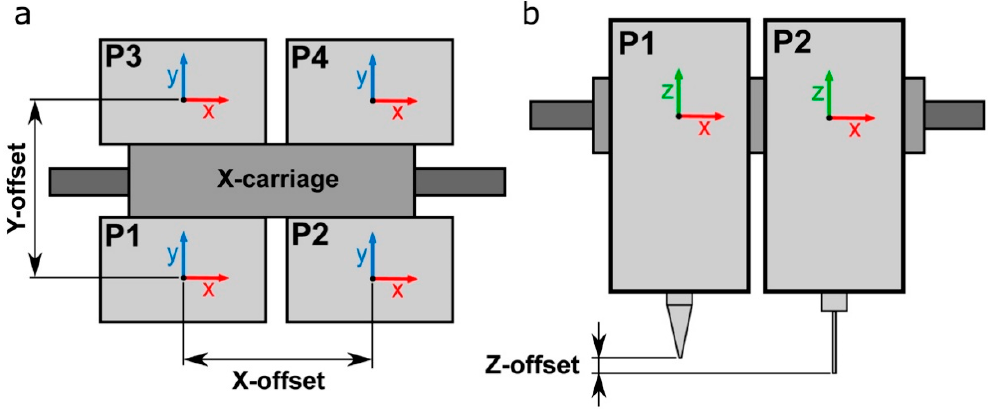
Figure 5. Schematic representation of the ( a ) XY-offsets and the ( b ) Z-offset of four printheads P1/P4.